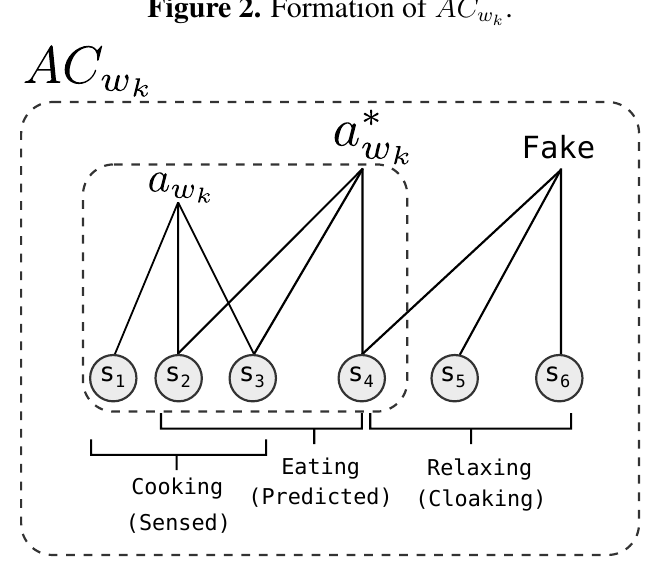
Figure 2. Formation of AC